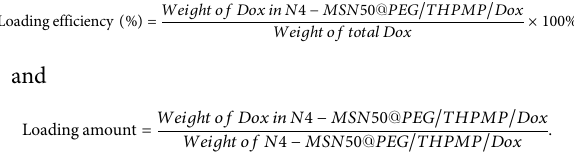
Frontiers in Chemistry |